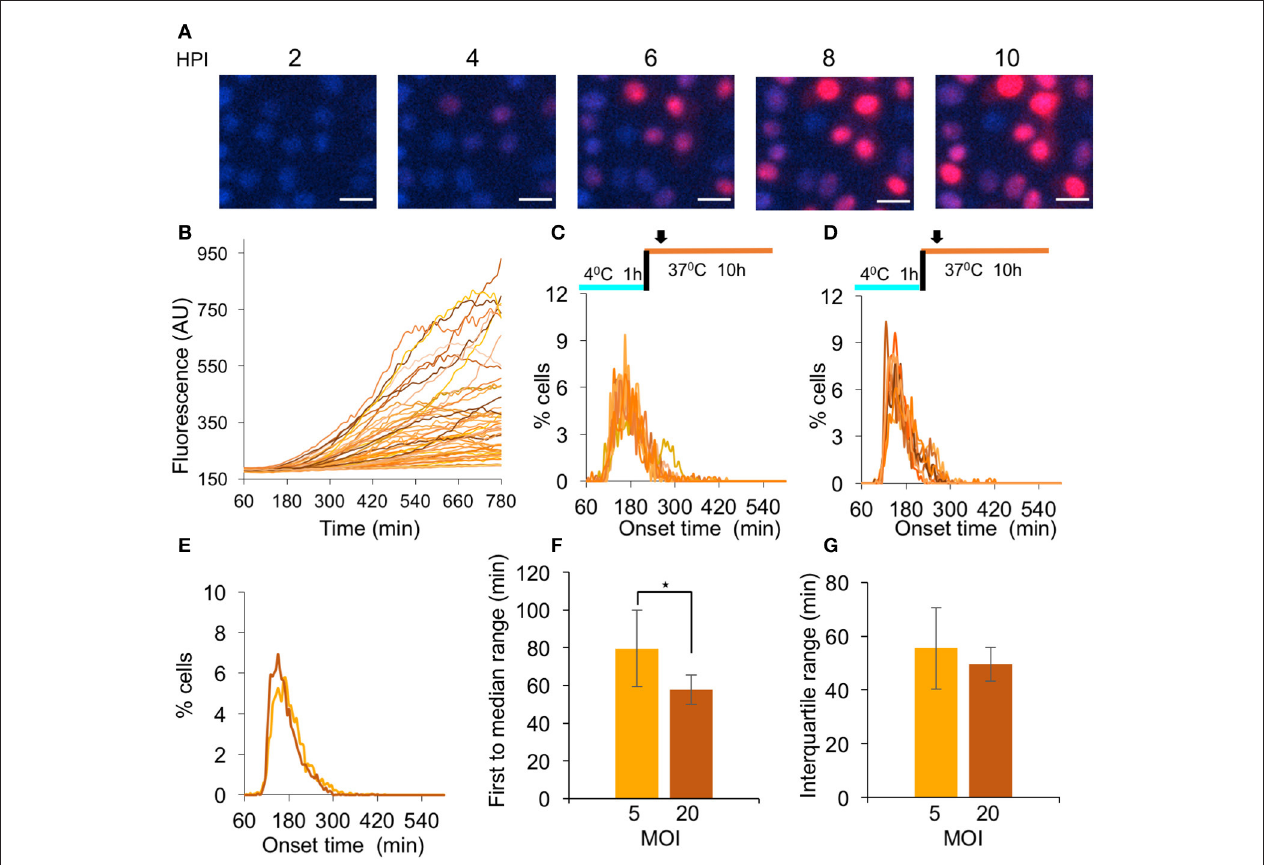
FIGURE 2 | Analysis of HSV-1 simultaneous gene expression. (A–C) Cells infected with OK11 recombinant at MOI 5 were monitored for 12h. (A) Snapshots of cells at different time points (as indicated) are presented. Nuclei are colored with Hoechst stain in blue, mCherry fluorescence in red. Scale bar 20 µ m. (B) The red fluorescence profiles in arbitrary units (AU) for individual cells during the infection were plotted. (C) Each histogram presents the percent of cells at each time point, that initiated expression (binning every 5min) in a single well; eight wells from two experiments done on different days were plotted. (D) Same histograms as C for cells infected with OK11 recombinant at MOI 20. (C–D) The infection conditions are schematically illustrated above each graph. Arrows represent imaging starting time ( ∼ 1h from last temperature shift). (E–G) Comparison between the onset times of expression for infections at MOI 5 (light orange) and MOI 20 (dark orange). (E) The average histograms for each condition were plotted. (F) The time between the first cell onset of expression to the median cell onset (first to median range) were plotted for each condition. (G) The interquartile range was plotted for each condition. (F–G) Error bars represent the standard deviation among the different wells. * P < 0.05 by student T